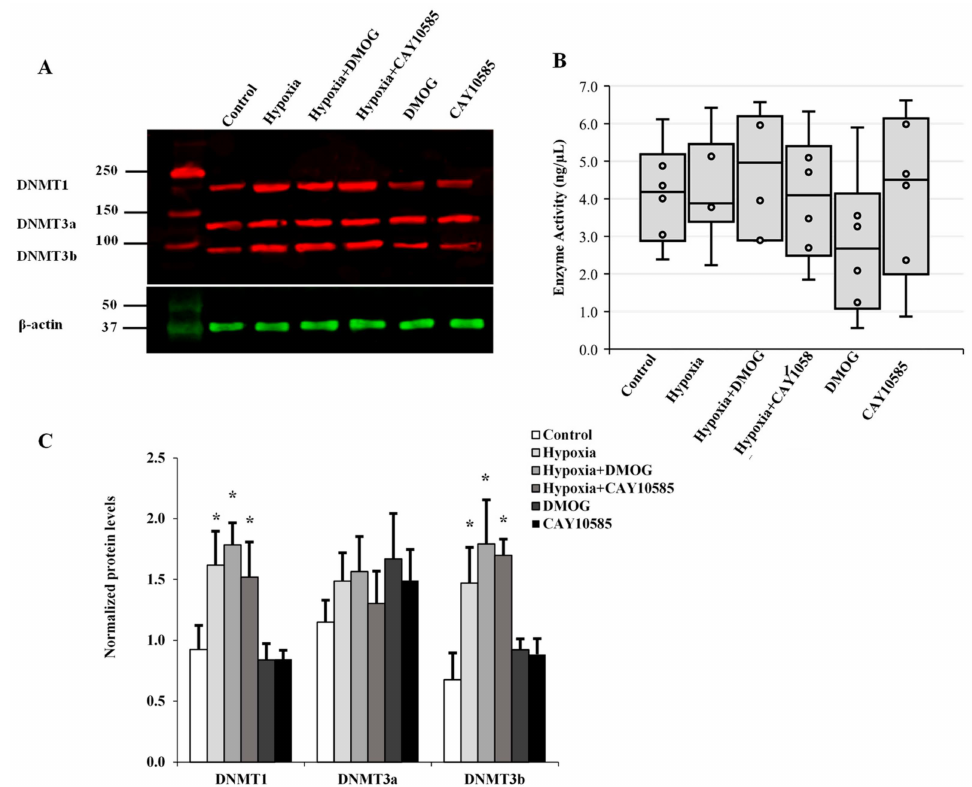
Figure 6. The role of DNMTs in hypoxia-induced adipocytokine hypomethylation in di ff erentiated adipocytes. ( A ) Western blot analysis and quantification of the normalized signal intensity of DNMT1, DNMT3a, and DNMT3b ( C ) and DNMT enzymatic activity ( B ) in adipocytes cultured under hypoxic and normoxic conditions for 24 h. Results represent the means ± SD for three independent experiments in triplicates for each treatment (n = 9). (* p < 0.05) for comparison with